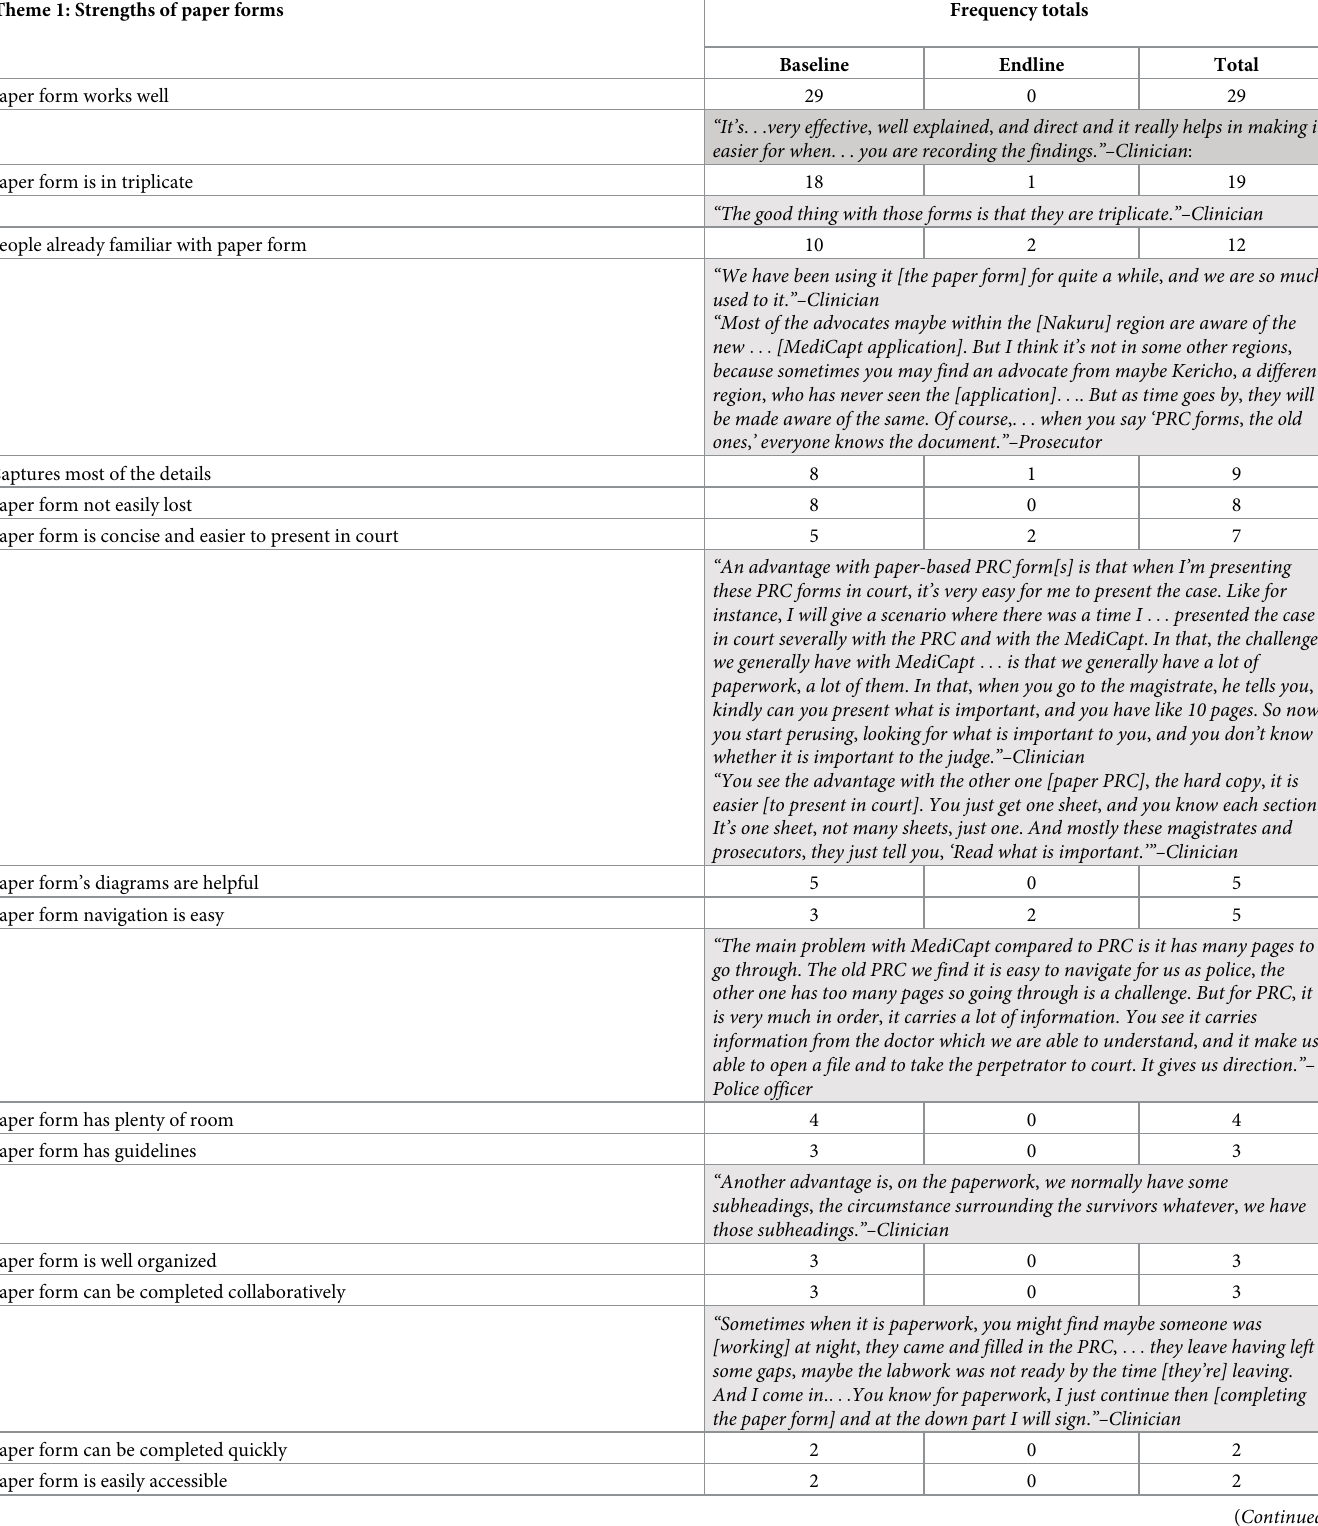
Table 4. Themes from key-informant interviews, listed by frequency at baseline, endline, and total, along with illustrative quotations as relevant. Theme 1: Strengths of paper